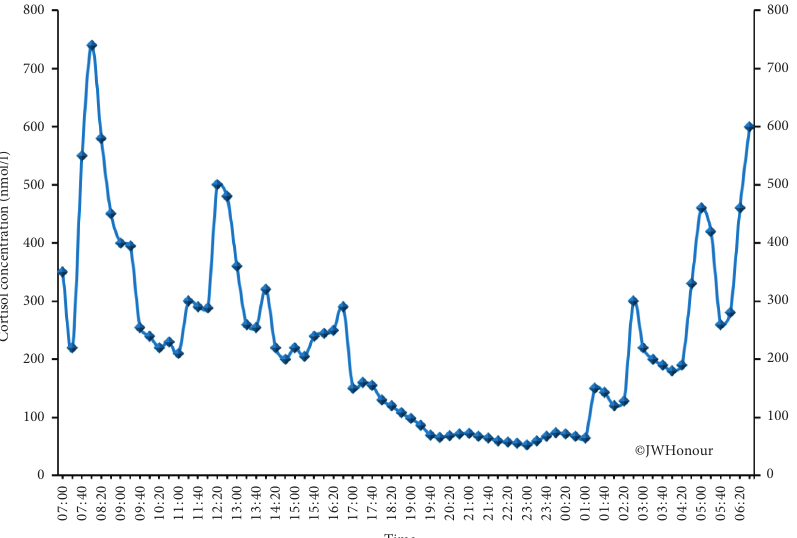
Figure 1: Circadian rhythm of plasma cortisol concentrations in a single normal male volunteer aged 55 years. Samples are obtained at 20- minute intervals (see